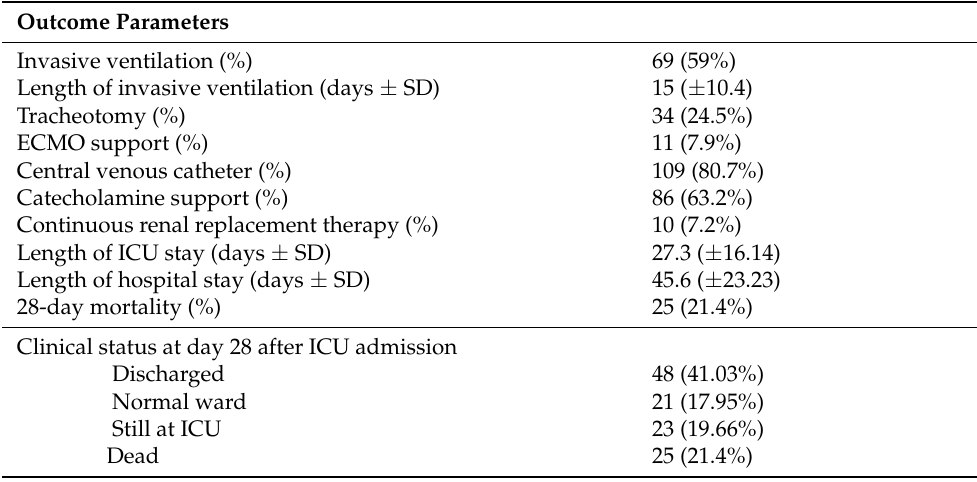
Table 2. Outcome parameters of all 117 included